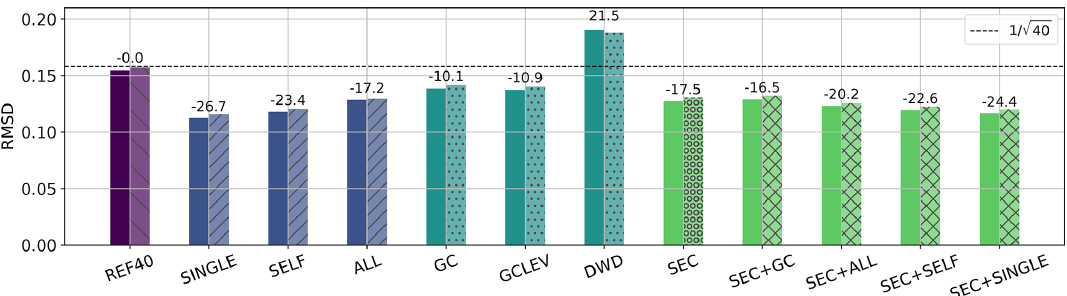
Figure 9. Root mean square difference before and after localization of 40-member vertical subsample correlations. EOL and Gaspari–Cohn scales are obtained and tuned using the first eight forecasts. Errors are evaluated using two independent forecasts on 2 June 2016: 03:00UTC (opaque) and 15:00UTC (hatched). Numbers (%) indicate the average change in RMSD analyzed for different settings ( x -axis